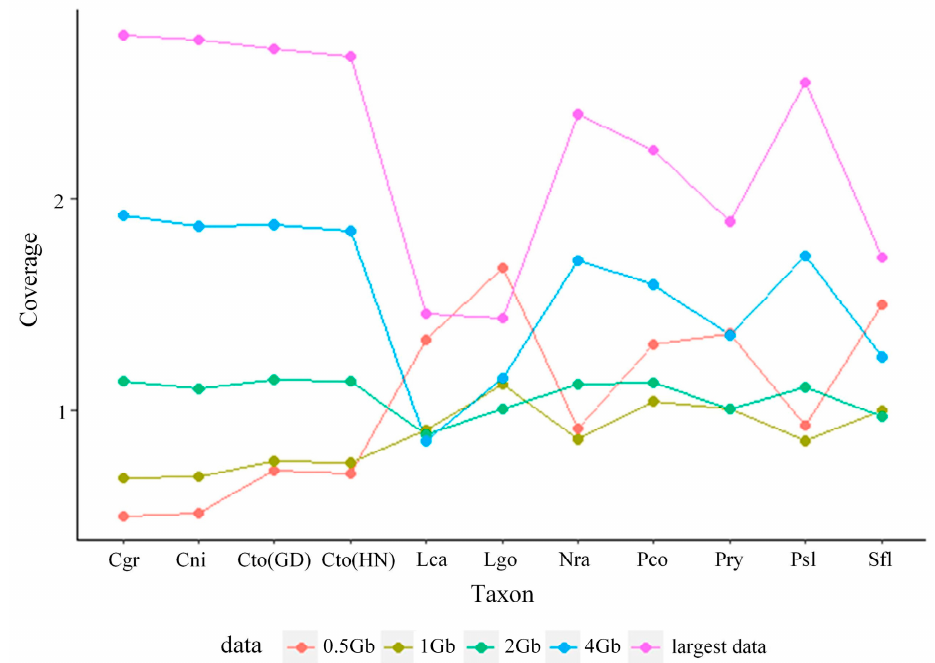
Figure 1. Coverage distribution of P. saccharina lanx (Psl), P. conulus (Pco), P. ryukyuensis (Pry), C. toreuma (GD) (Cto-GD), C. toreuma (HN) (Cto-HN), C. grata (Cgr), C. nigrolineata (Cni), L. goshimai (Lgo), L. cassis (Lca), N. radula (Nra), and S. flexuosa (Sfl) under different sizes of genome